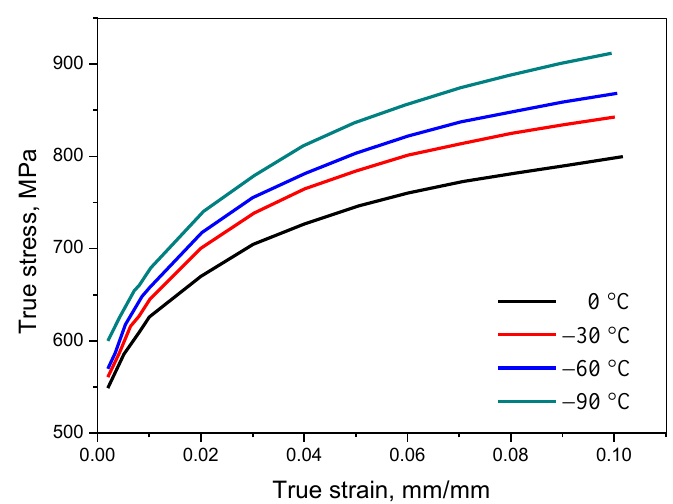
Figure 2. True stress-strain curves in coarse-grained heat affected zone (CGHAZ) of X80 at various temperatures [25].